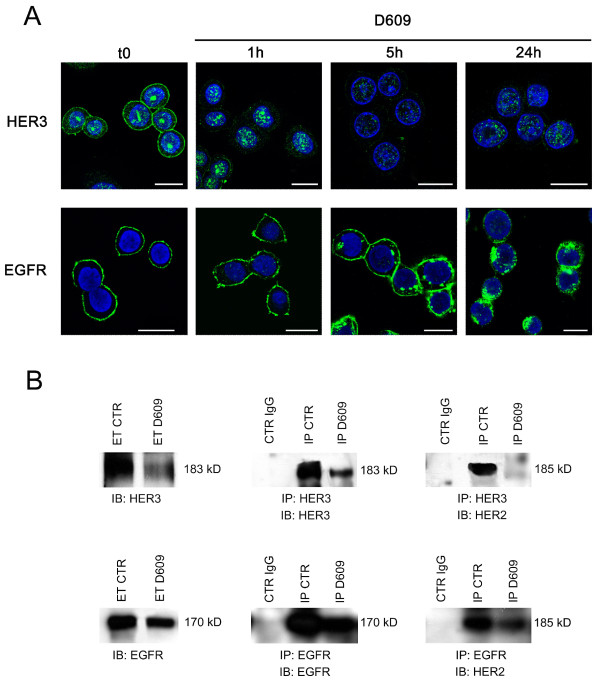
Effects of PC-PLC inhibition on EGFR and HER3 internalization, overall receptors' contents and heterodimer formation with HER2. (a) CLSM analyses of fixed SKBr3 cells after exposure to D609 for different time intervals and stained with either α-HER3 (upper panels) or α-EGFR antibodies (lower panels). Nuclei were stained with DAPI (blue). Scale bars, 20 μm. (b) Immunoblotting (IB) and immunoprecipitation (IP) experiments on SKBr3 cells, incubated with D609 for 24 hours, to detect overall HER3 and EGFR contents (left panels) and their levels of heterodimerization with HER2 (right). Central panels show the efficiency of the α-HER3 and α-EGFR antibodies in immunoprecipitating the respective target receptors. ET CTR, total extract of control cells; ET D609, total extract of D609-treated cells; CTR IgG, control IgG of α-HER3 or α-EGFR antibodies; IP CTR, immunoprecipitation from control cells; IP D609, immunoprecipitation from D609-treated cells. Representative examples of two independent experiments are shown.